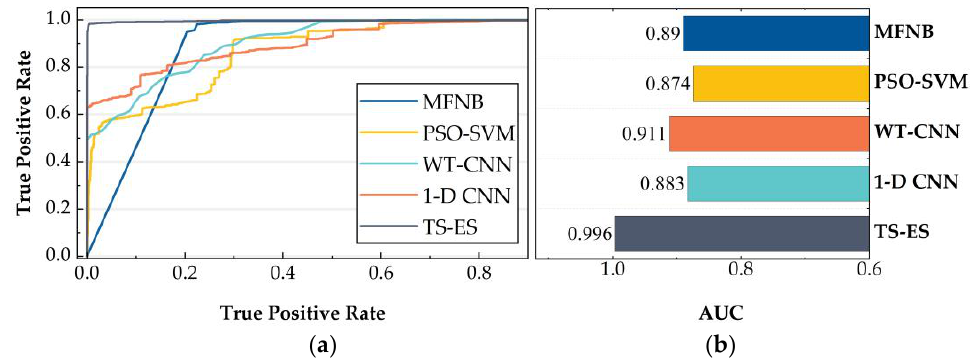
Figure 11. ROC and AUC of each method. ( a ) ROC. ( b ) AUC. Table 5. Comparison of the accuracy, abnormal signal precision and abnormal signal recall. Accuracy Precision Recall